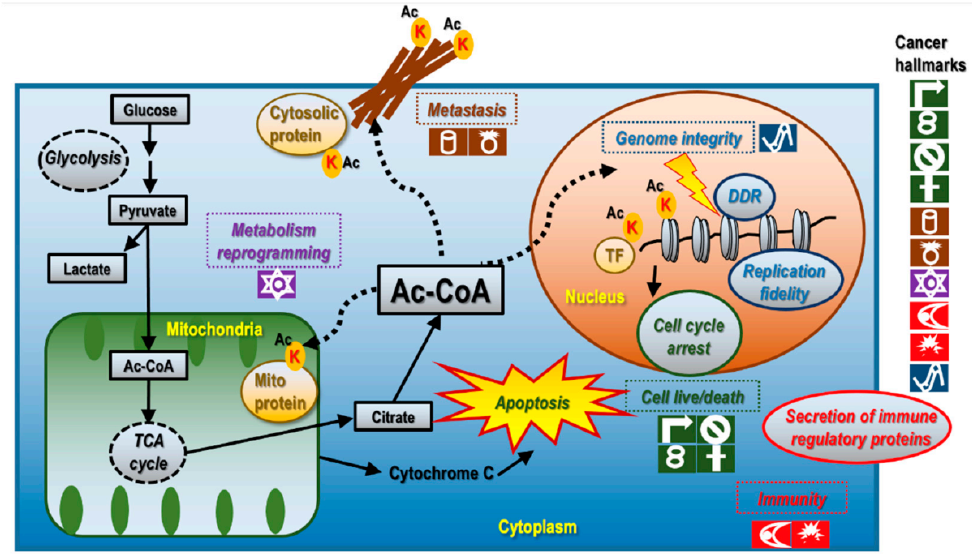
Figure 2. Associations between lysine acetylation and cancer hallmarks. Lysine acetylation dynam- ically interacts with cancer cell metabolism as acetyl-CoA is the acetyl-donor of acetylation, and acetylation could modulate cell metabolism if occurring on proteins affecting the expression of TFs or enzymes involved in cellular metabolism. Lysine acetylation, if residing in genes regulating core elements of adaptive or innate immune response, could lead to aberrant immune and inflammatory responses. Lysine acetylation is involved in genome integrity control as it could orchestrate the DDR machinery activities via modulating chromatin structure where many DDR events occur and could thus affect replication fidelity. Lysine acetylation could modulate cancer cell live/death and metastasis as it can occur on histone or non-histone proteins relevant to DDR, cell cycle progression and